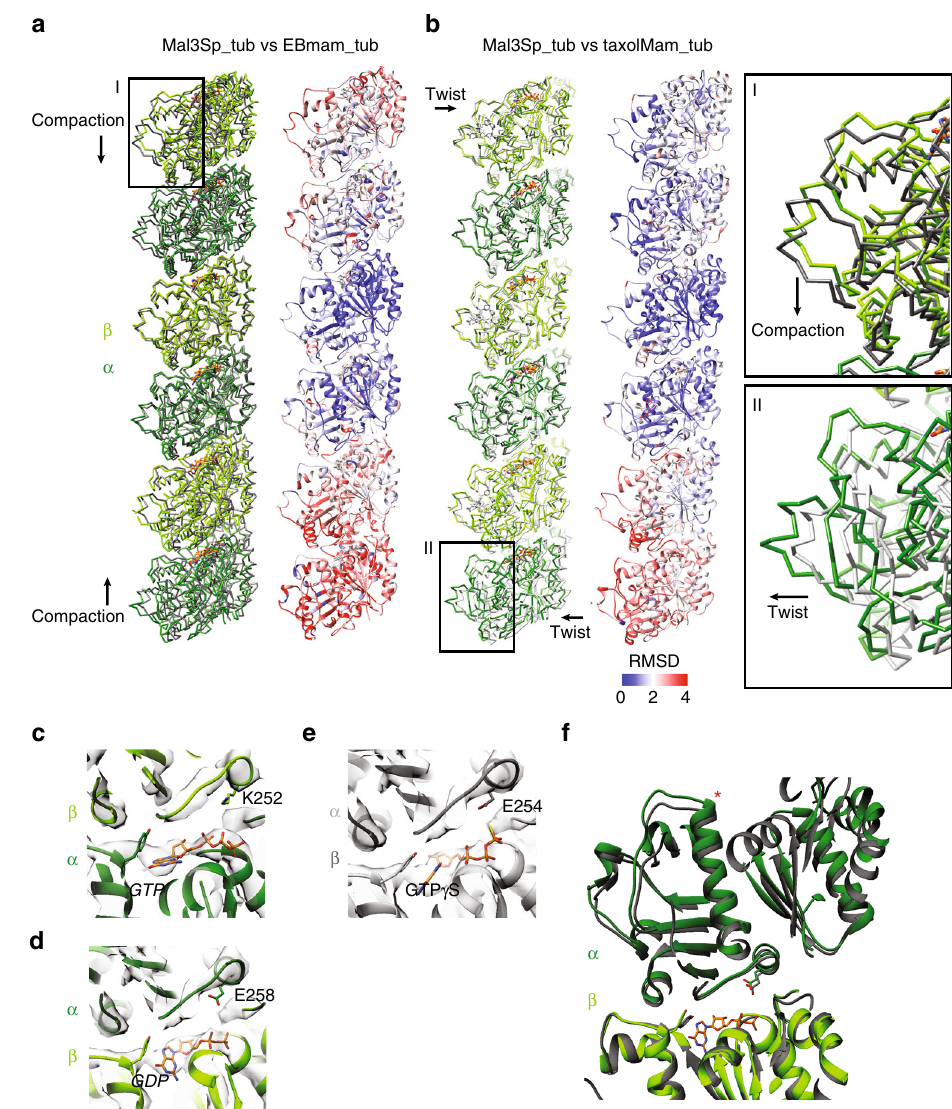
Fig. 4 Structure of longitudinal Sp_tub PFs reveals an extended tubulin repeat while supporting GTP hydrolysis. a Overlay (left) and RMSD (right) of 3 dimers from a Mal3 + Sp_tub PF (green) with the EB3 + Mam_tub (gray) PF aligned on the central β -sheet of β -tubulin in the middle tubulin dimer, showing lack of the longitudinal PF compaction in Mal3 + Sp_tub that is present in EB3 + Mam_tub. b Overlay (left) and RMSD (middle) of 3 dimers from a Mal3 + Sp_tub (green) PF with the Taxol + Mam_tub (gray) PF aligned on the central β -sheet of β -tubulin in the middle tubulin dimer, showing a similarly extended PF structure in each. This also shows the intrinsic skew of the Mal3 + Sp_tub PFs that is not exhibited in the Taxol + Mam_tub MTs. Right, box I, zoomed view of Mal3 + Sp_tub vs EB3 + mam_tub overlay, indicating the direction of nucleotide-dependent compaction seen in EB3 + mam_tub but absent in Mal3 + Sp_tub. Box II, zoomed view of Mal3 + Sp_tub vs Taxol + Mam_tub overlay, indicating the direction of lattice twist in Mal3 + Sp_tub relative to Taxol + Mam_tub. c Mal3 + Sp_tub α -tubulin N-site with Sp_tub molecular model docked (dark green). d Mal3 + Sp_tub β -tubulin E-site with Sp_tub molecular model docked (light green). e Mal3 + Sp_tub β -tubulin E-site with EB3 + Mam_tub molecular model docked (gray) [+ GTP γ S]. f Overlay of the E-site of Mal3 + Sp_tub (green) with the EB3 + Mam_tub (gray) aligned on the E-site, showing lack of the longitudinal dimer compaction in Mal3 + Sp_tub that is present in EB3 + Mam_tub, highlighted by the difference in positions of α -tubulin H7 (red visualized at near-atomic resolution (Supplementary Fig. 1c). For simplicity, numbering of residues for α -tubulin1 is used below.